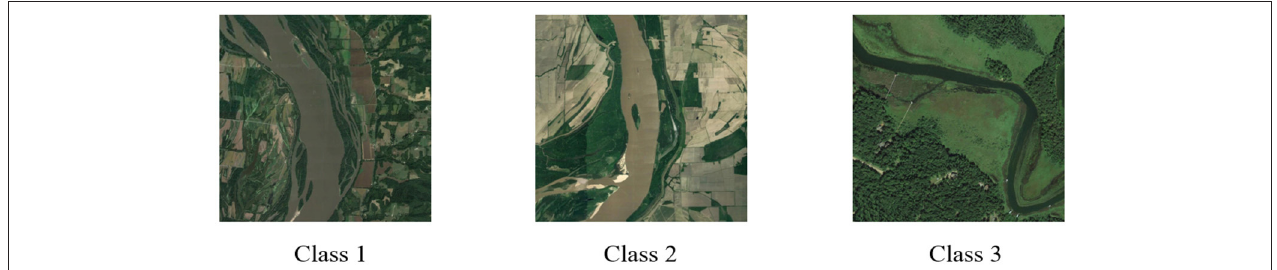
FIGURE 10 | Different classes of rivers with varying color distribution and greenery.